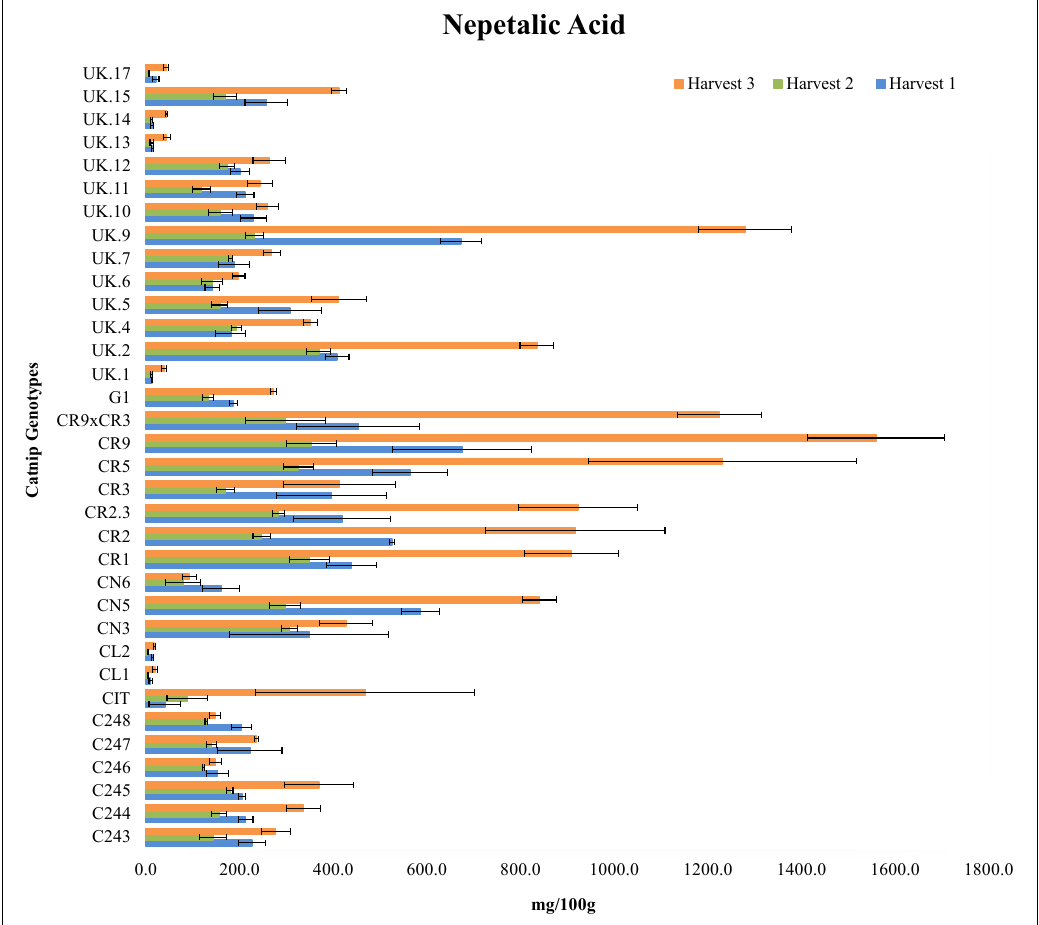
Figure 2. Nepetalic Acid (NA) content (mg/100 g) of catnip genotypes at three different harvest times. Pittstown NJ, USA, 2017 and 2018. Error bars represent standard errors. Harvest 1 = July 2017,